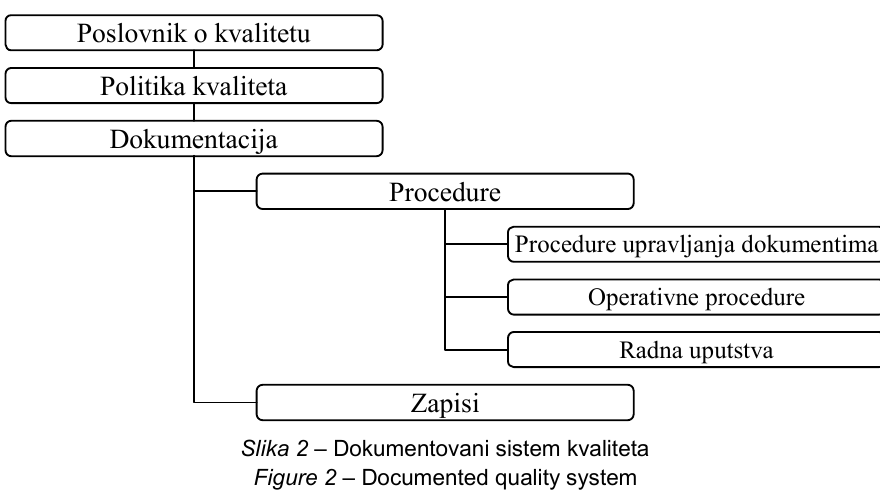
Figure 2 – Documented quality